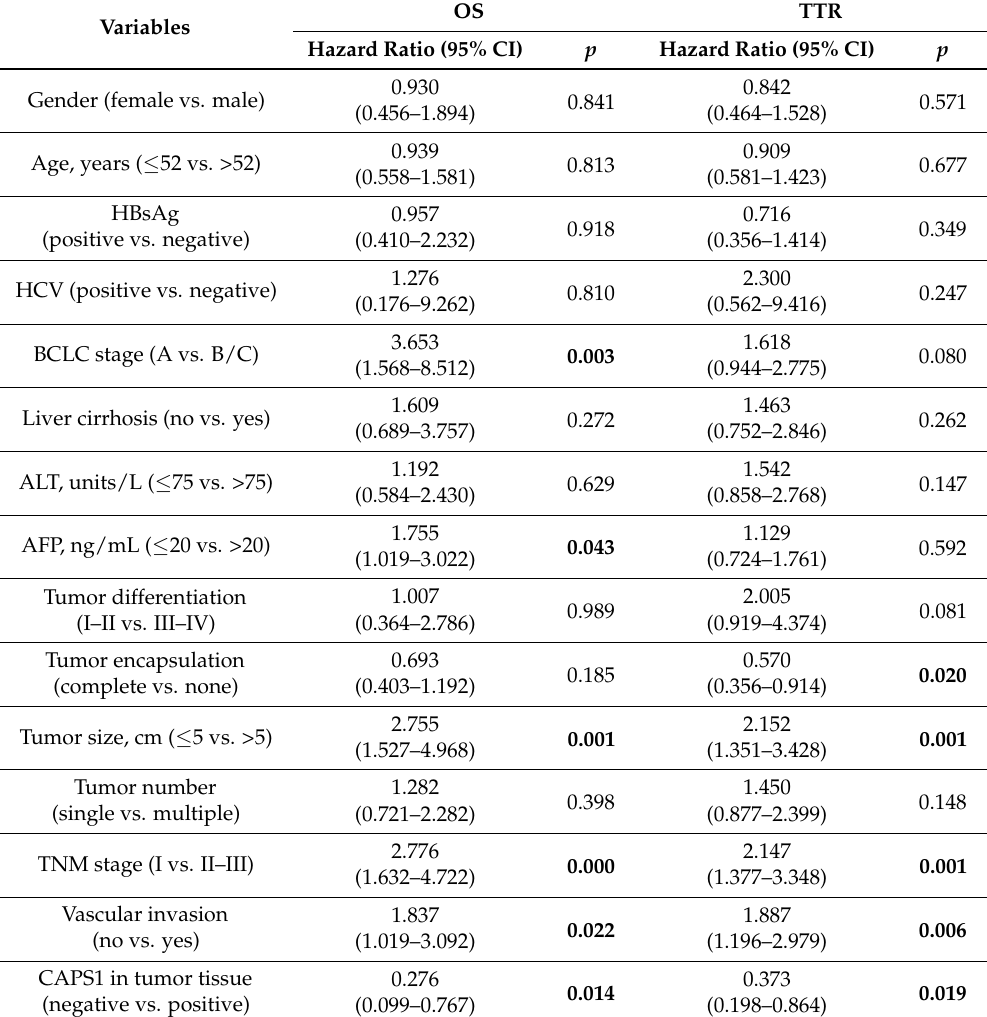
Table 2. Univariate analysis of factors associated with survival and